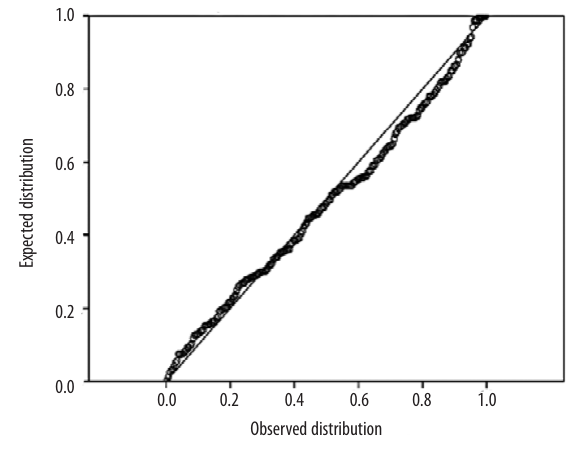
Fig. 3. Normal P-P Plot of the model